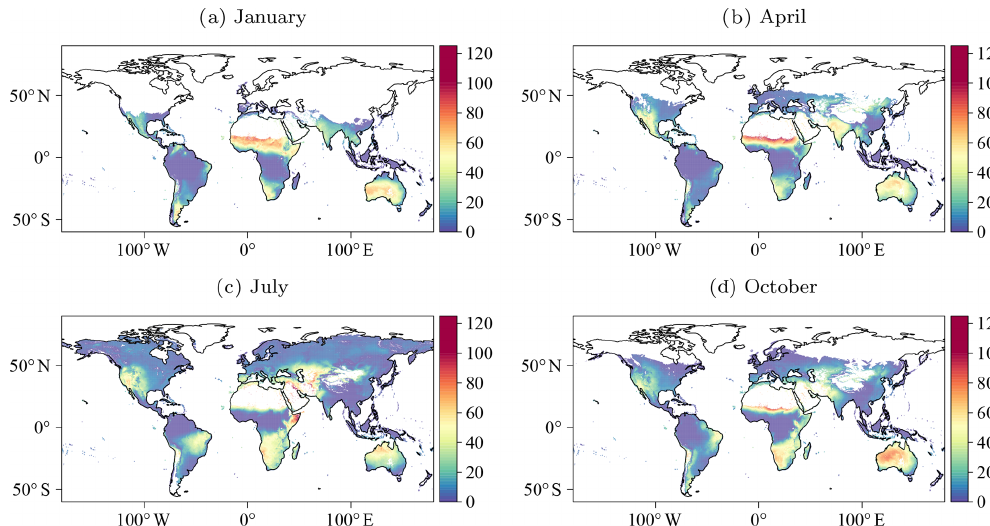
Figure 1. Monthly climatologies of mean FWI values for January (a) , April (b) , July (c) , and October (d) . Barren areas (e.g. the Sahara) and any locations where overwintering is active for greater than 50% of the temporal record are masked out. Barren areas are further masked using land cover data available from Li et al. (2018), part of the ESA Climate Change Initiative – Land Cover led by UCLouvain (2017). Map displayed in World Geodetic System 1984 projection (WGS84,